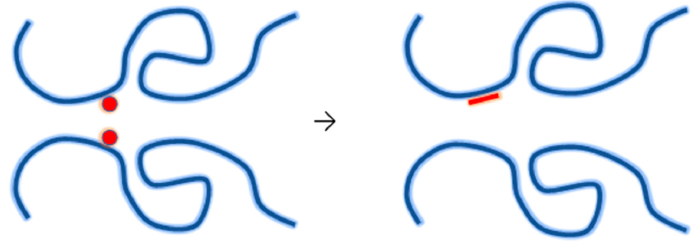
Figure 20. Intermolecular disproportionation of two carbon-centered polymer radicals.